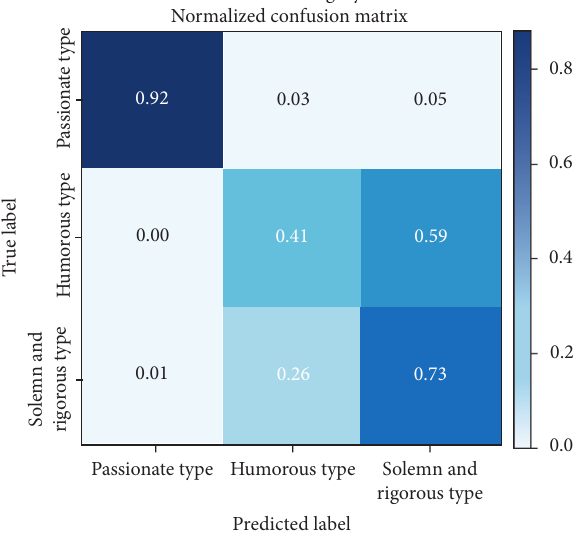
Figure 2: Statistical model: display of the evaluation performance of the “evaluation of teaching style” indicator.